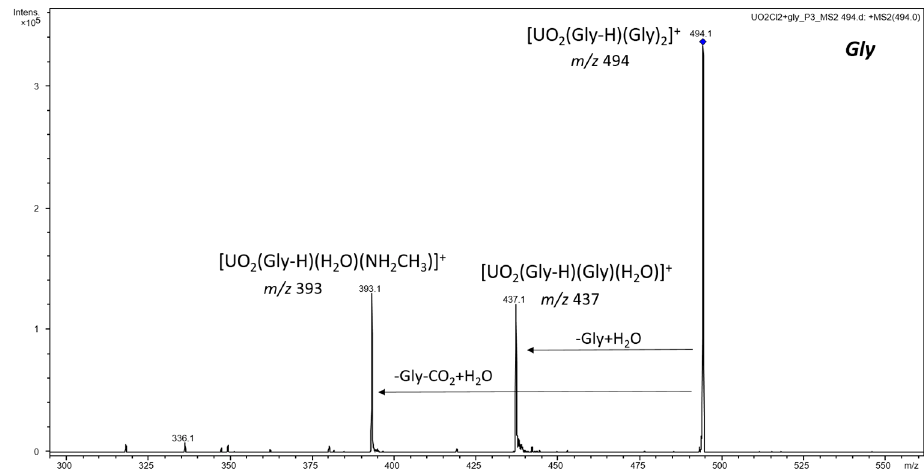
Figure 3. CID mass spectrum of [UO 2 (Gly-H)(Gly) 2 ] + .